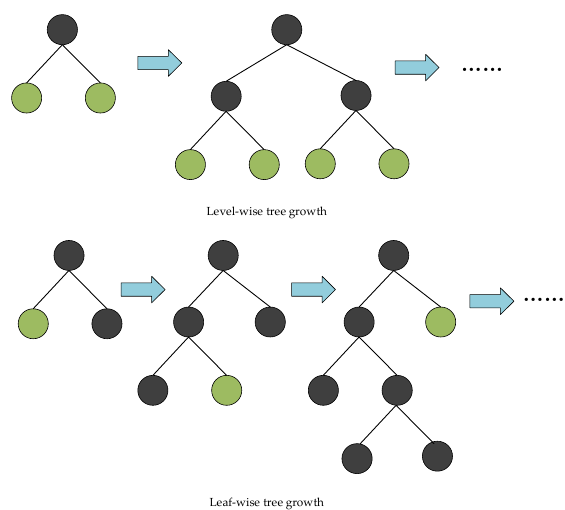
Figure 1. The strategy of tree growth in LightGBM.